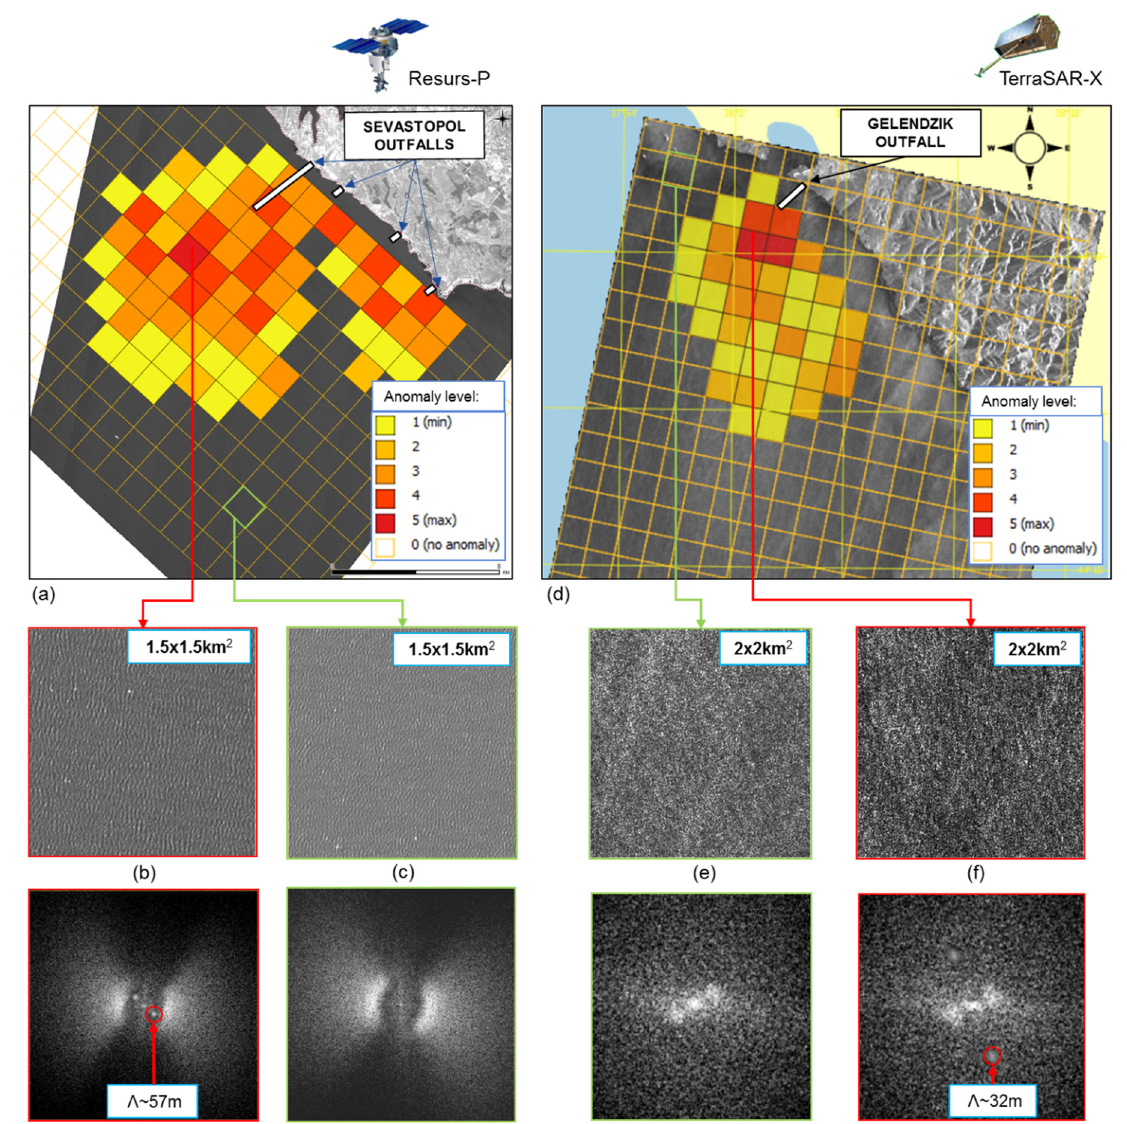
Figure 4. Example results from spatial spectral processing of high-resolution satellite images: ( a ) optical panchromatic Resurs-P No. 1 image of the region of Sevastopol; ( d ) TerraSAR-X radar image for the region of Gelendzhik. Fragments of original satellite images and corresponding 2D spatial spectra in the areas of effluent of submerged discharge ( b , f ) and in background areas ( c , e ).